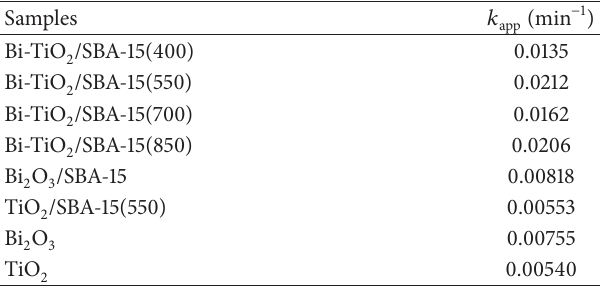
Table 2: The rate constant of Bi-TiO todegradation.